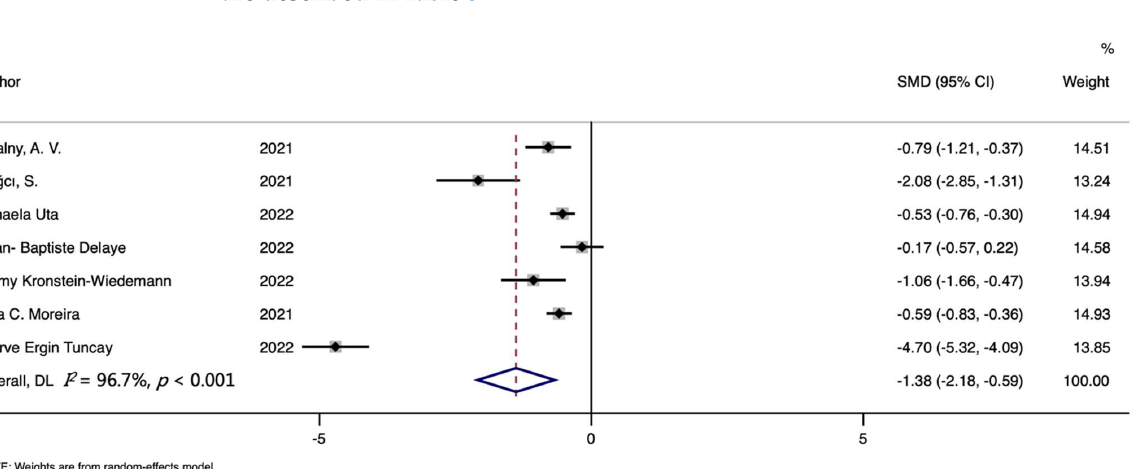
Figure 4. Forest plot of standard mean difference (SMD) with corresponding 95% confidence intervals (CIs) of studies [7–13,22] on serum iron levels in non-survivors and survivors. The solid diamond and horizontal line represent the study-specific effect and 95%CI, respectively; the size of the grey square is positively correlated with the weight distributed to each study in the meta-analysis. The center of open diamond with the vertical dashed line expresses the pooled SMD, and the width expresses the pooled 95%CI. Seven studies were included in the serum iron and COVID-19 risk meta-analysis, including 492 cases and 704 controls. Figure 5 showed that lower serum iron levels were found in cases than controls (SMD (95%CI): −1.384 (−2.175, −0.592); Z = 3.43 p for Z = 0.001; I 2 = 96.7%, p for I 2 < 0.001; Table 3). In the subgroup analysis by continent, the same difference was discovered between Asia (SMD (95%CI): − 3.403 ( − 5.974, − 0.832); Figure S1) and Europe (SMD (95%CI): − 0.580 ( − 0.791, − 0.370); Figure S1). More details are described in Table 3.